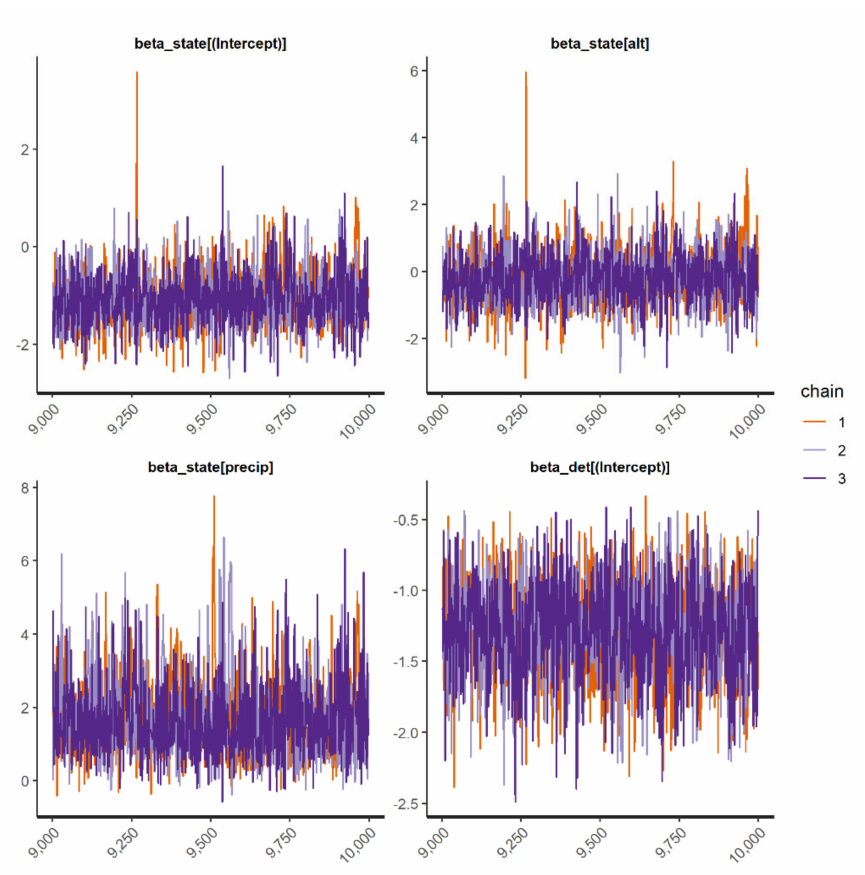
Figure A17. Traceplots from the best occupancy model of feral horse ( Equus ferus caballus ) in Puerto Rico: ( ψ (intercept + elevation + precipitation); ρ (intercept)). Note: alt = elevation; precip = mean annual precipitation.